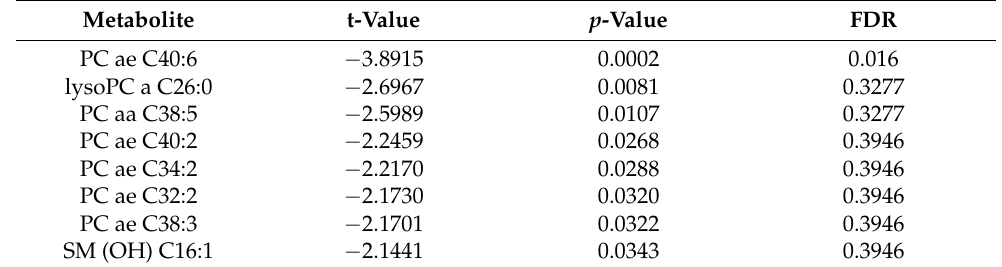
Figure 2. MV-based metabolomics allows the differentiation between healthy controls and breast cancer patients in blood plasma. T-statistics ( a ) reveal eight significant metabolites ( p ≤ 0.05, two- tailed unpaired Student’s t-test, relevant metabolites are colored in pink) and multiple logistic regression ( b ) for combined Receiver operator characteristic (ROC) analysis of PC ae C40:6, lysoPC a C26:0, PC aa C38:5, PC ae C34:2, PC ae C32:2, PC ae 38:3 and SM (OH) C16:1. Table 3. T-statistics revealed eight significant metabolites differentiating breast cancer patients from the controls.